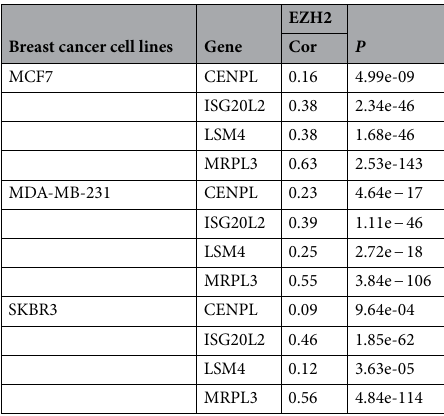
Table 4. correlation analysis between novel four hub genes (CENPL, ISG20L2, LSM4 and MRPL3) and EZH2 based on RNA in situ detection. Cor: Pearson correlation